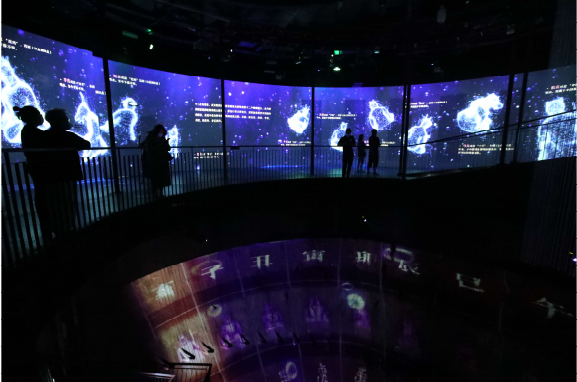
Figure 2. RE - International Center for Digital Creativity 1-1